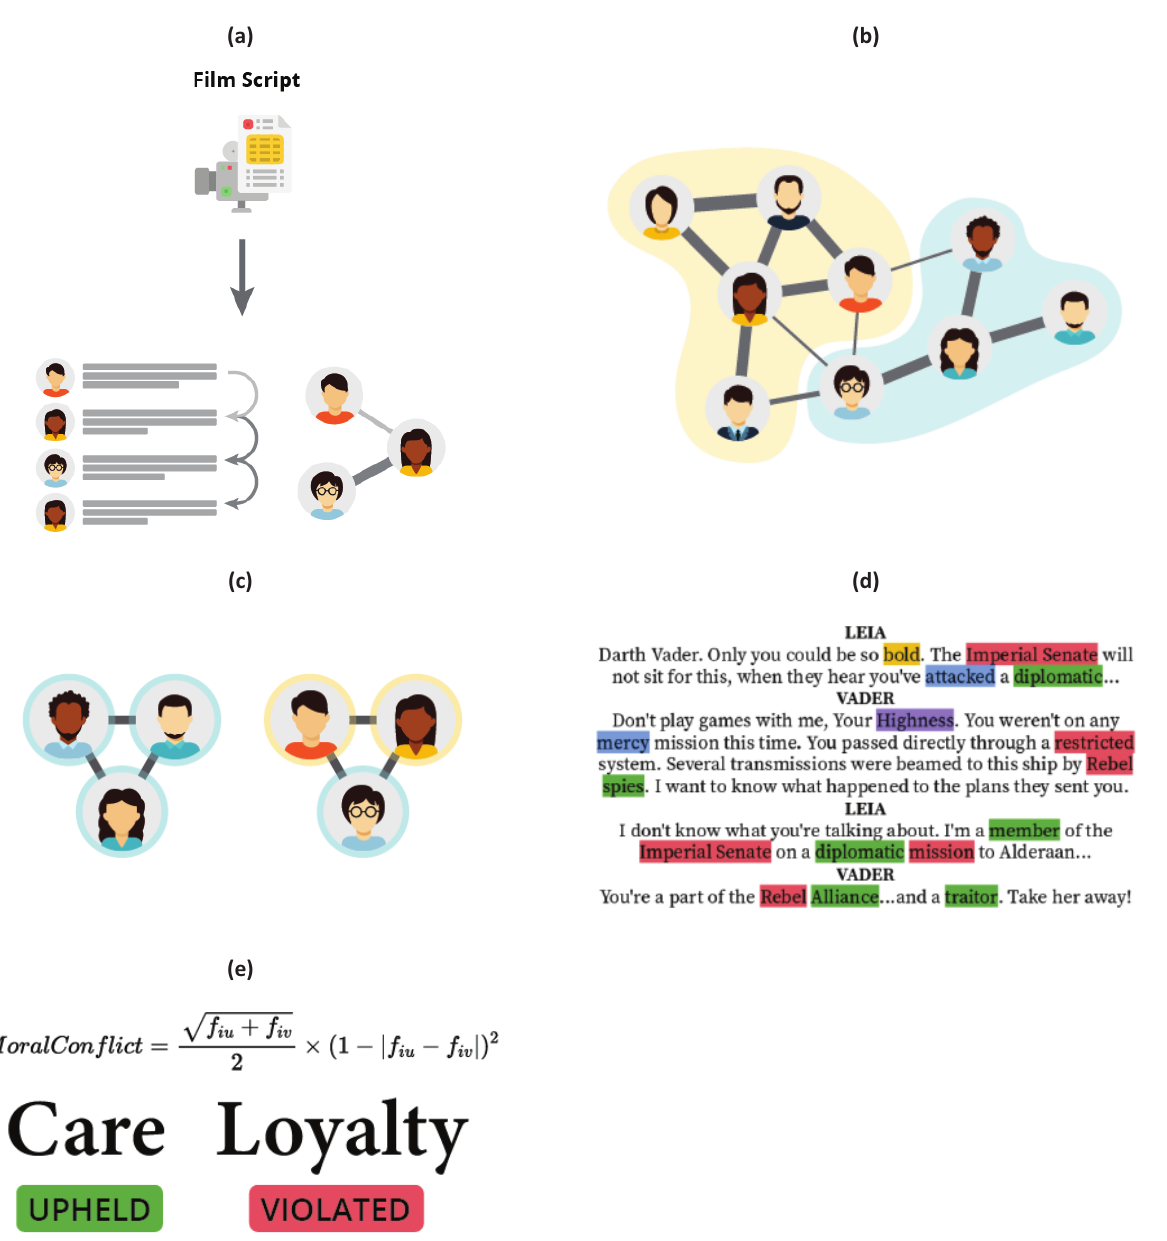
Figure 3. Flowchart of the Moral Conflict Detection Pipeline: (a) Network construction; (b) Modularity maximization; (c) Extracting within-module (left) and cross-module (right) scenes; (d) Coding moral content; (e) Calculating moral conflict. Source: